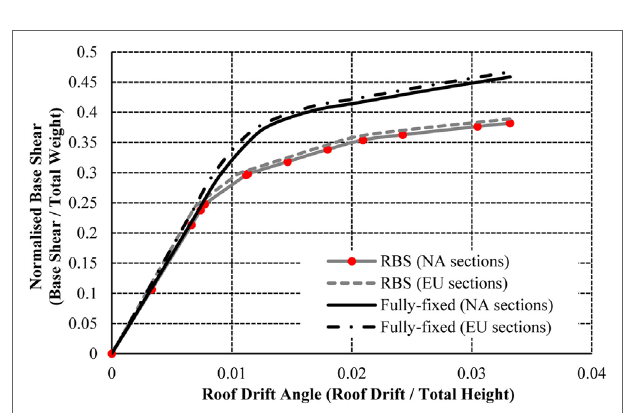
Figure 7 | 4-storey frame normalized capacity curve